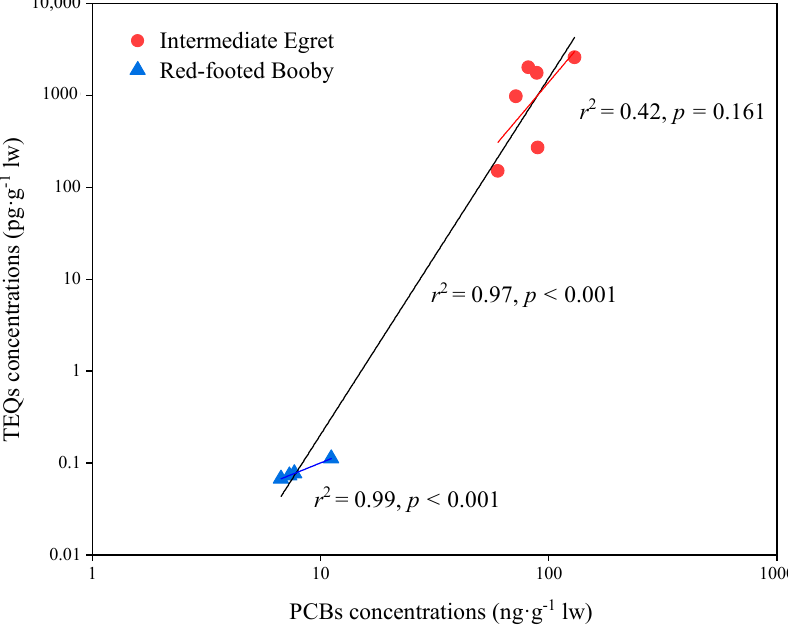
Figure 5. Correlations between PCBs and TEQ concentrations in birds from Qilianyu Island.